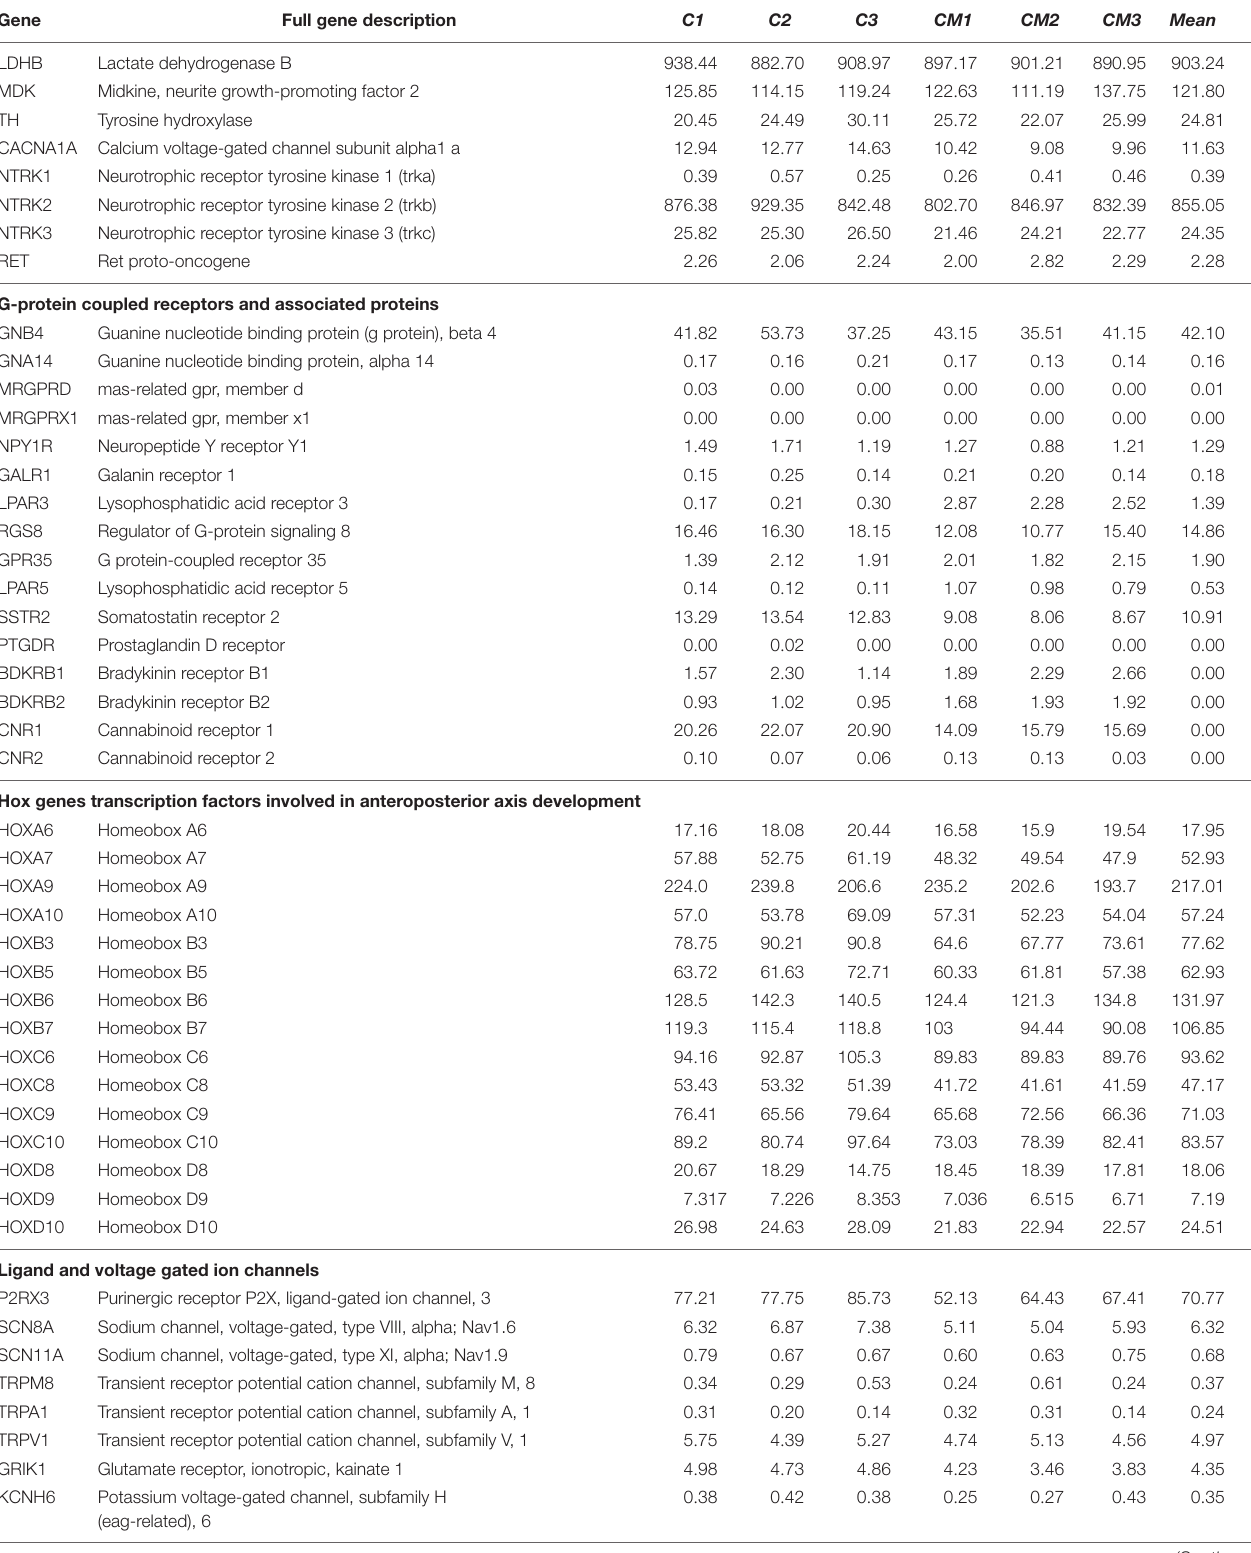
TABLE 1 | RNA-Seq data of the main sensory neuronal markers expression in transcripts per million (TPM). Gene Full gene